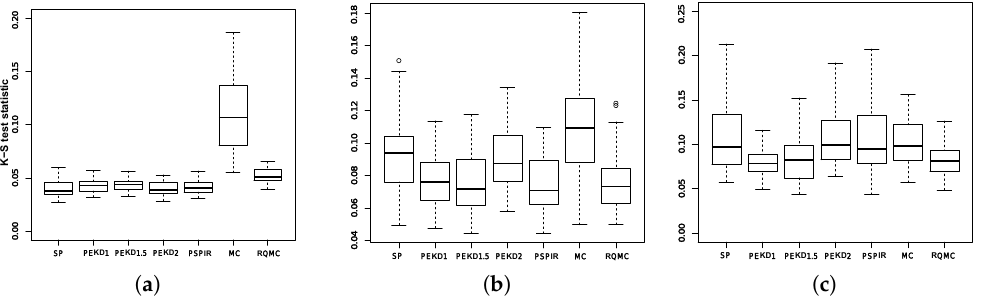
Figure 6. Box plots of K-S test statistic for three test functions on uncertainty propagation of computer experiments. The smaller, the better. ( a ) g 1 ( x ) ; ( b ) g 2 ( x ) ; ( c ) g 3 ( x )